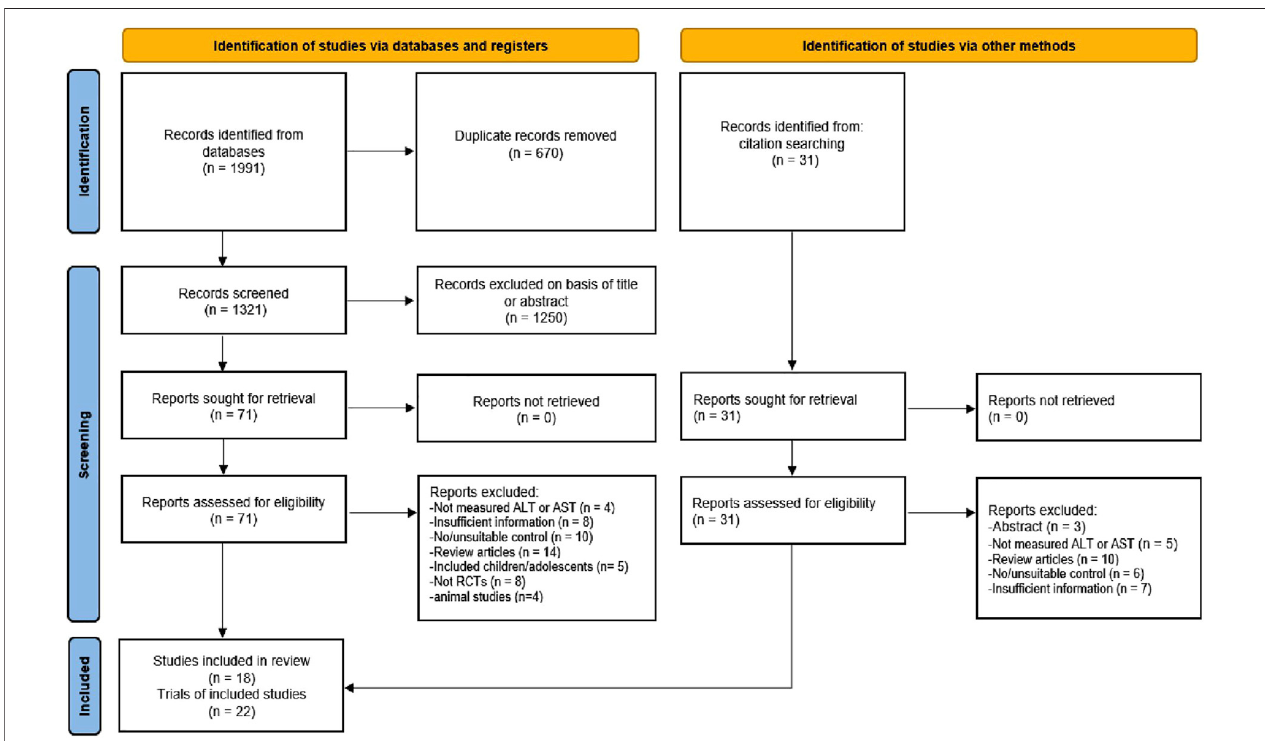
FIGURE 1 | Flowchart of the study selection according to the latest Preferred Reporting Items for Systematic Review and Meta-Analysis (PRISMA).